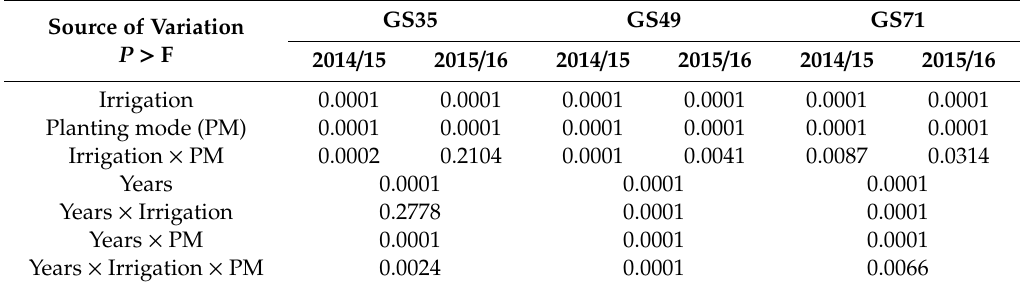
Table 3. Analysis of variance (ANOVA; p -values) for soil water content of winter wheat at growth stage 35 (GS35), GS49 and